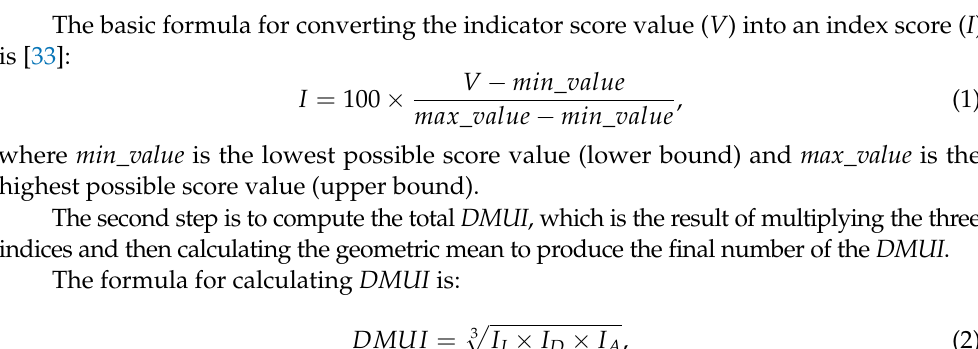
Figure 3. Components and sub-components of the